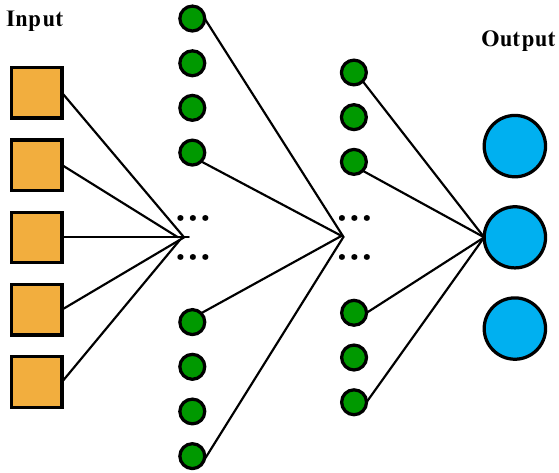
Figure 3. The network model of the multi-ship system. To ensure the stability of convergence, the DQN algorithm was adopted, which stores the current state, action, return value and next state in a replay buffer, sampling through the greedy policy [35], which is a deterministic policy of making the locally optimal choice at each stage with the hope of finding a global optimum. Only when the value function was maximized, the probability was 1 and the other action’s probability was set to be 0. The goal of the system was to make the difference between the target Q network and the Q network as little as possible. More importantly, each ship agent was controlled by the DQN algorithm with the same structure and parameters. The training parameters of its network model are shown in Table 2. Table 2. Hyper parameters of the training